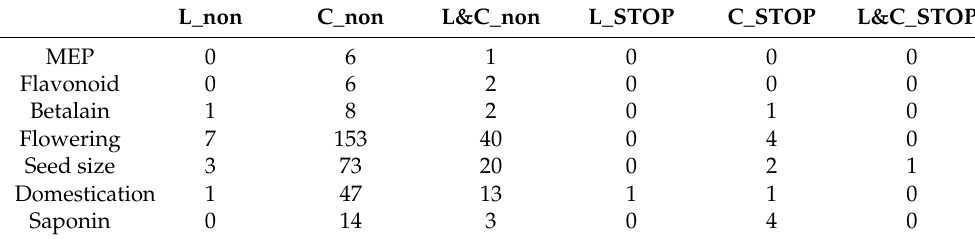
Table 1. Genomic variations of candidate genes in Longli-4 and